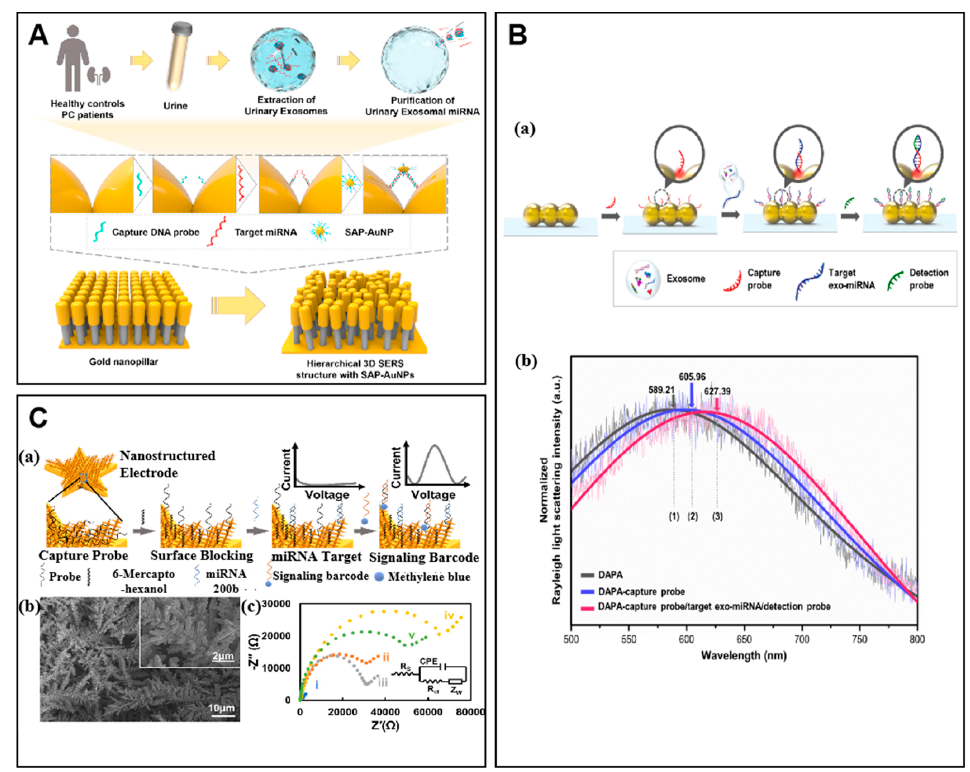
Figure 5. Examples of signal sensing strategies in exo-miRNA biosensors. ( A ) Schematic of the hierarchical 3D SERS structure-based exo-miRNA detection. Reprinted with permission from